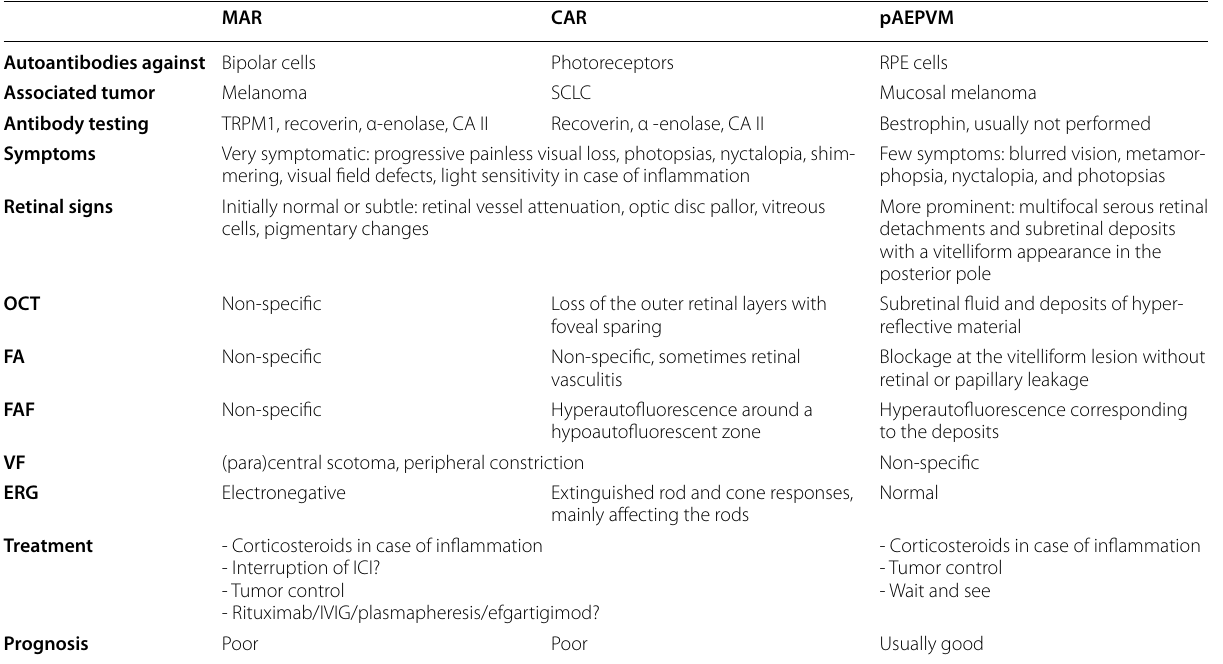
Table 4 Characteristics of paraneoplastic